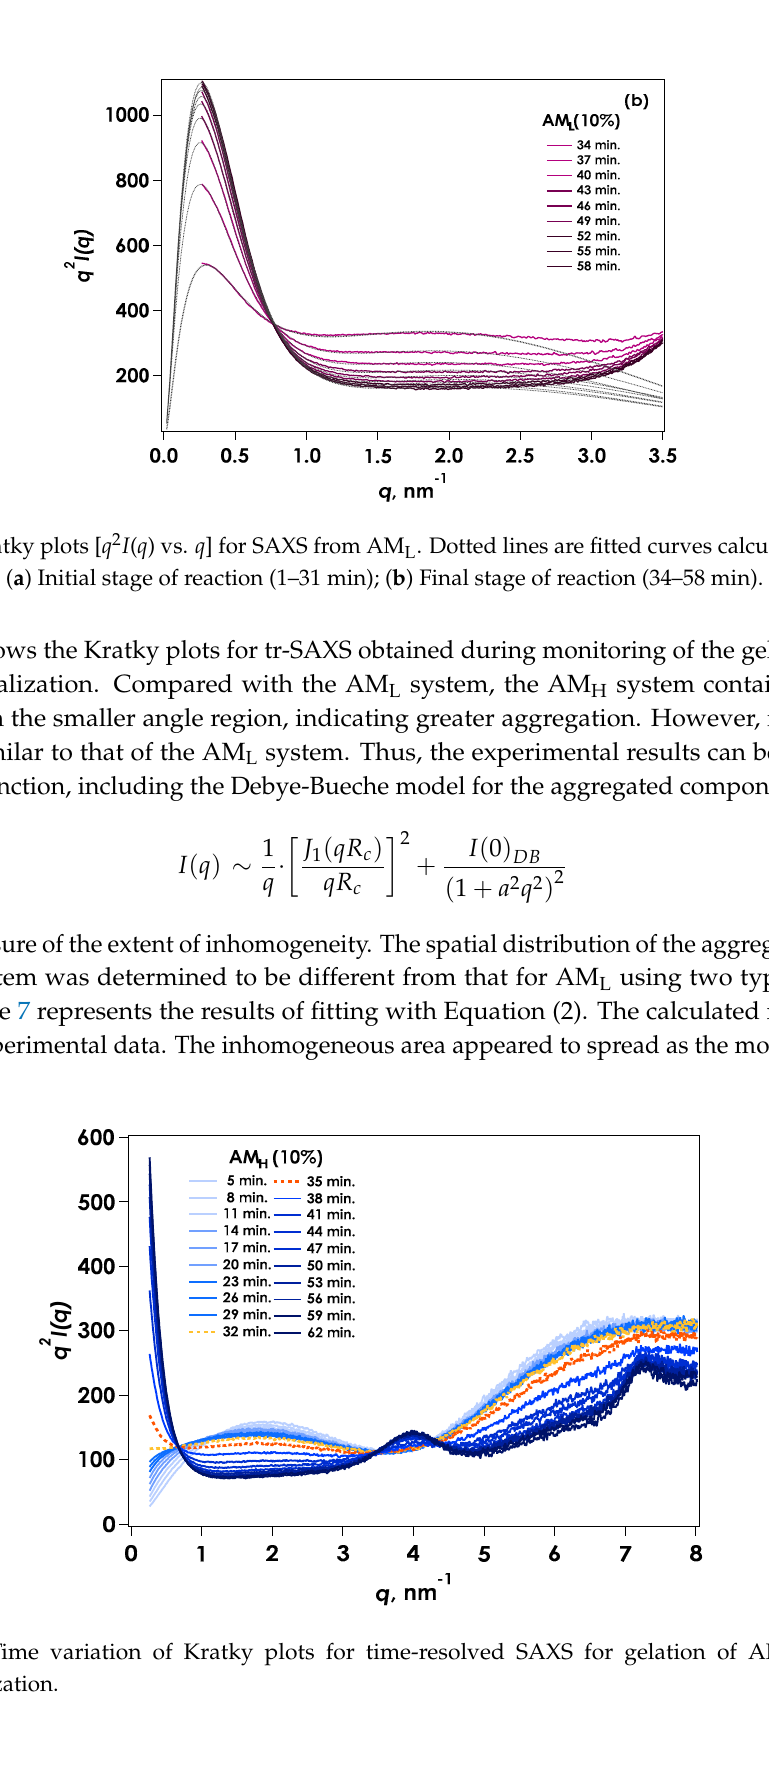
Figure 6. Time variation of Kratky plots for time-resolved SAXS for gelation of AM H by in situ neutralization.